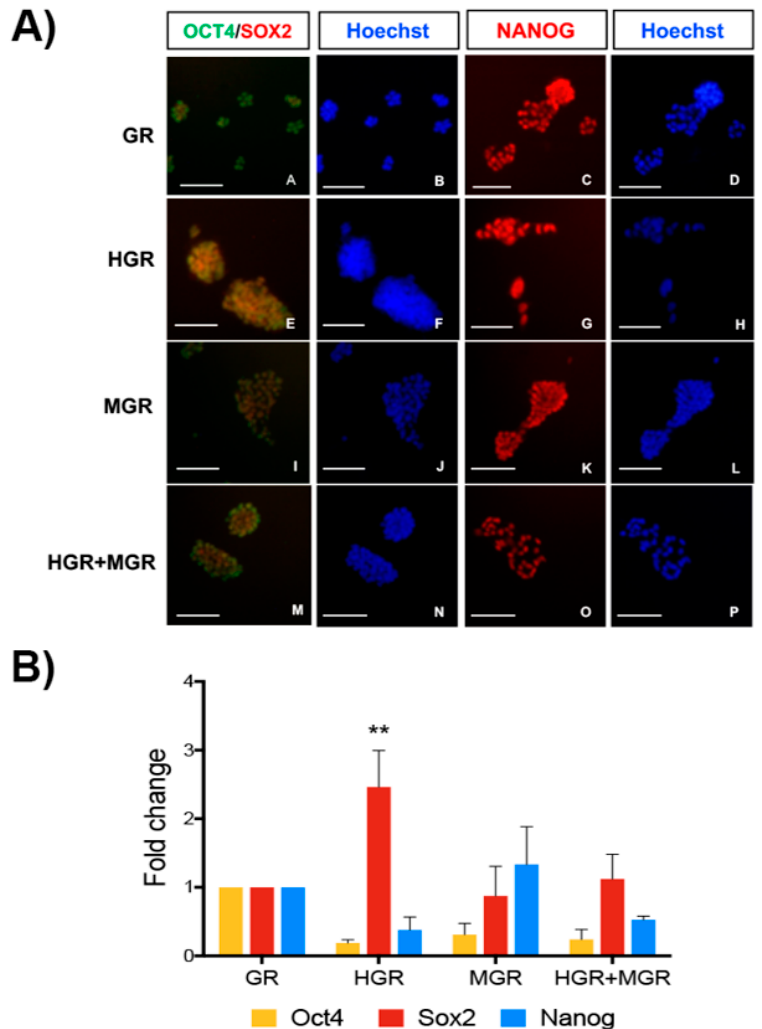
Figure 4. Transgenic mESCs remain pluripotent. ( A ) We evaluated the expression of OCT4, SOX2 and NANOG in the transgenic cells via immunofluorescence and observed that the selected clones continued to express these pluripotent factors. Scale bars = 100 µ m. ( B ) The expression of pluripotency factors was evaluated by RT-qPCR in all transgenic cell lines. Two-way ANOVA followed by Tukey’s test indicated only a significant difference in Sox2 expression for the HGR clone compared with the control GR clone after comparison of all cell lines. ** p < 0.0025.